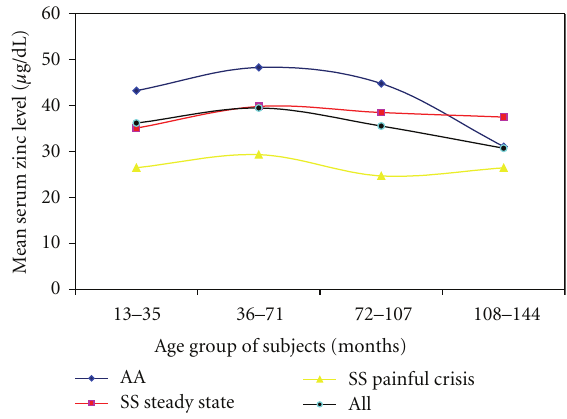
Figure 1: Mean zinc concentration by age groups in the three subgroups.